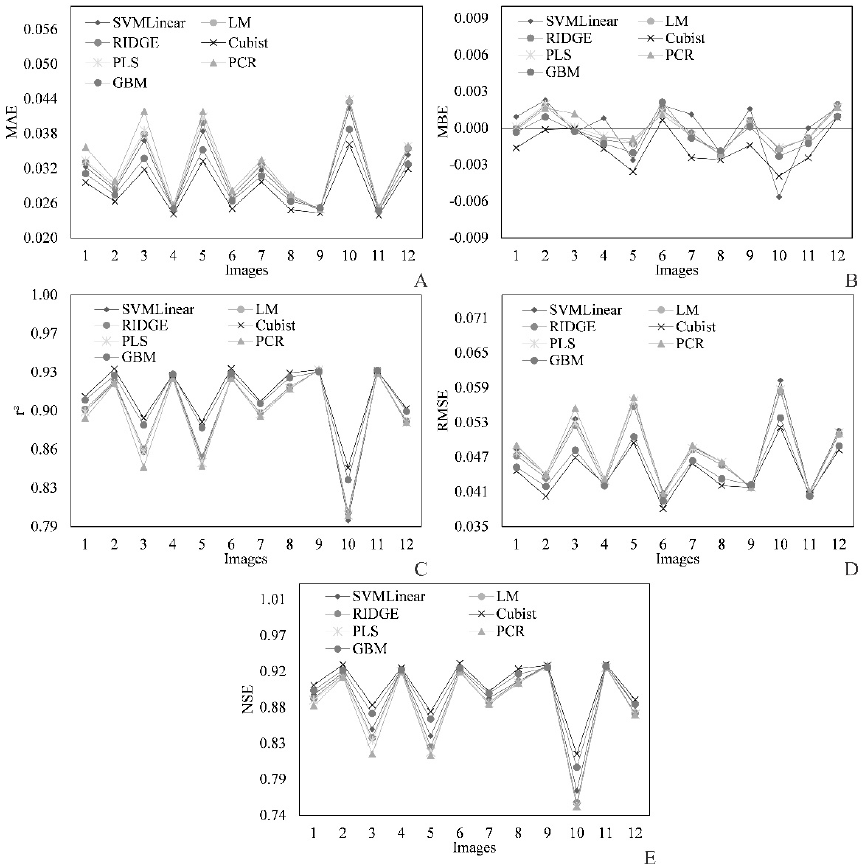
Figure 5. Statistical metrics of the MODIS-Landsat-like downscaling model for NDVI: ( A ) mean absolute error (MAE); ( B ) mean bias error (MBE); ( C ) determination coefficient (r 2 ); ( D ) root mean square error (RMSE), and ( E ) Nash–Sutcliffe efficiency index (NSE).